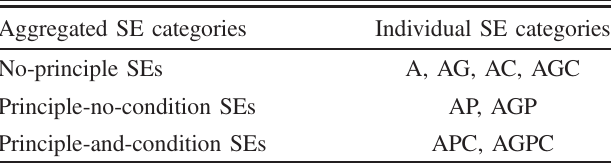
TABLE VIII. The aggregated self-explanation categories and their constituents.